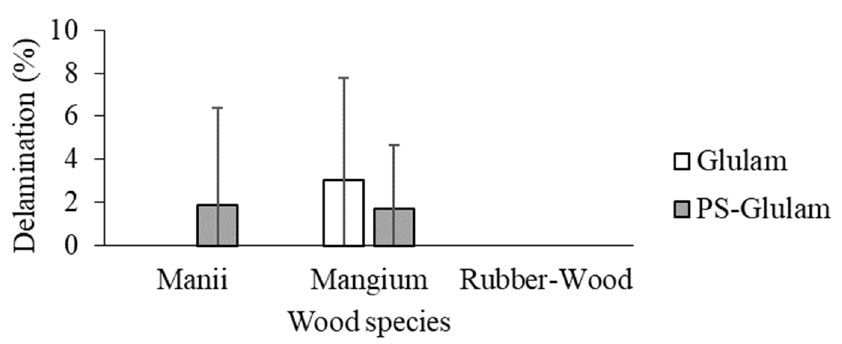
Figure 7. Delamination in hot water of glulam. PS = polystyrene.